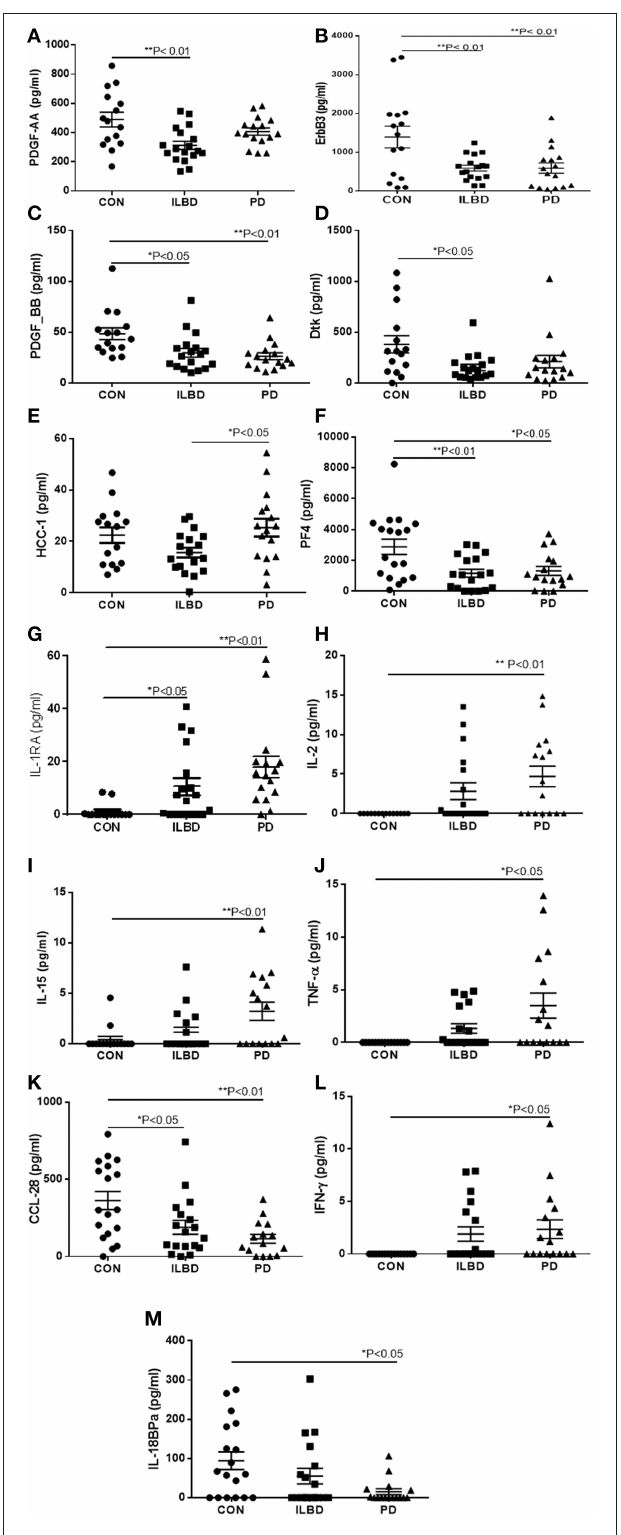
FIGURE 3 | Scatter plots showing distribution of results for proteins that showed disease group differences in striatum samples. Disease